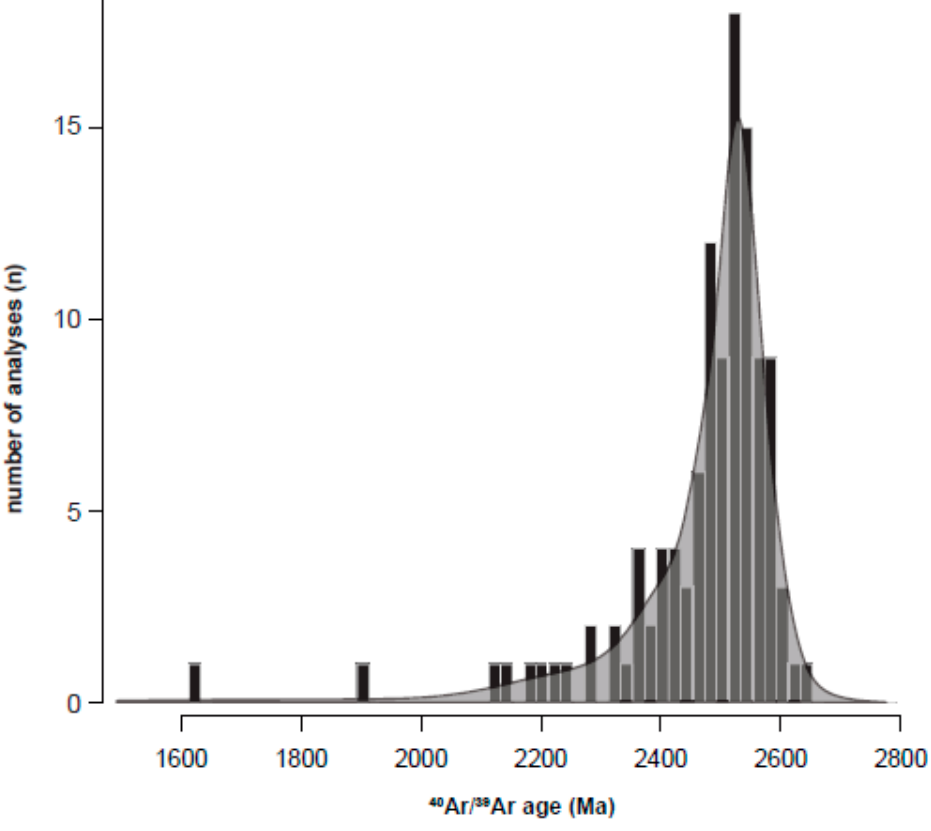
Figure 8. Histogram and density distribution diagram of 40 Ar / 39 Ar fusion analyses (n: 113) showing an Neoarchean to late Paleoproterozoic age population at ca. 2600–2390 Ma, and a peak of biotite ages at ca. 2550 Ma.